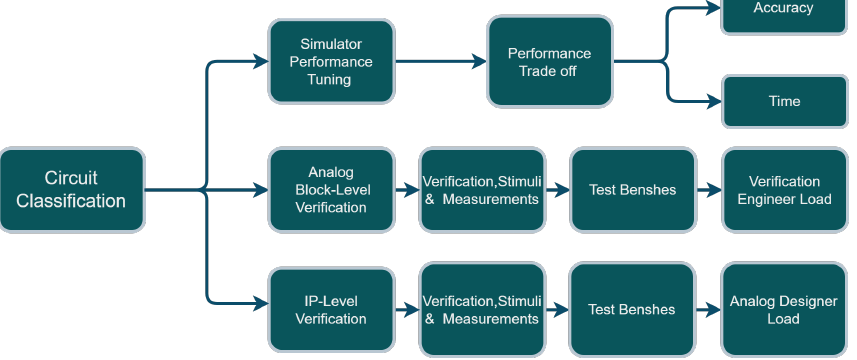
Figure 1. Circuit classification use cases: Simulator performance tuning, analog block-level verifica- tion, and IP-level